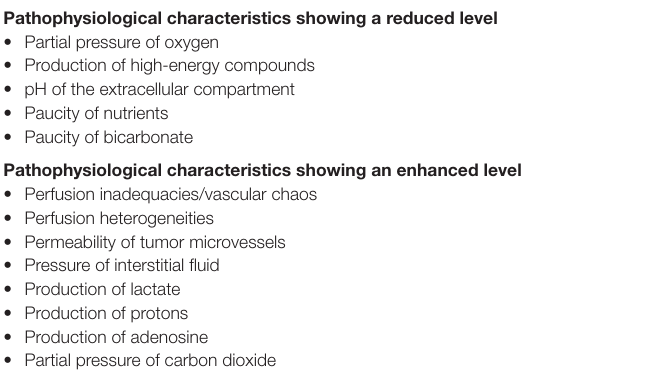
TABLe 1 | The crucial Ps characterizing the hostile tumor